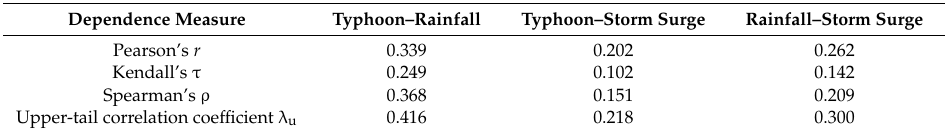
Table 4. Correlation among typhoons, rainfall, and storm surges.